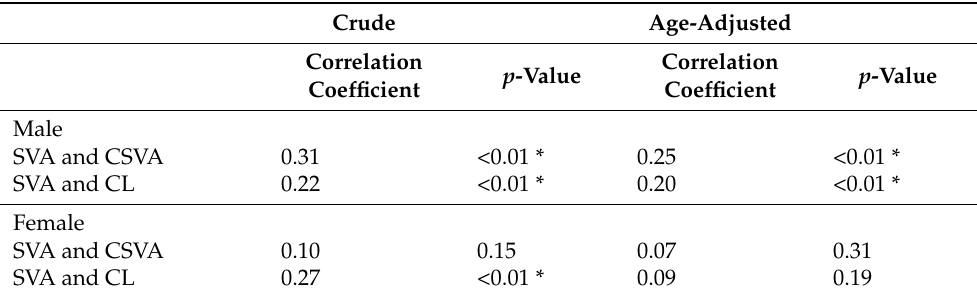
Figure 3. Relationship between subcervical alignment and cervical alignment parameters. Note: * denotes a significant association ( p < 0.05). Abbreviations: SVA, sagittal vertical axis; CSVA, cervical sagittal vertical axis; CL, cervical lordosis. Table 3. Relationship between subcervical alignment and cervical alignment parameters with and without age adjustment.